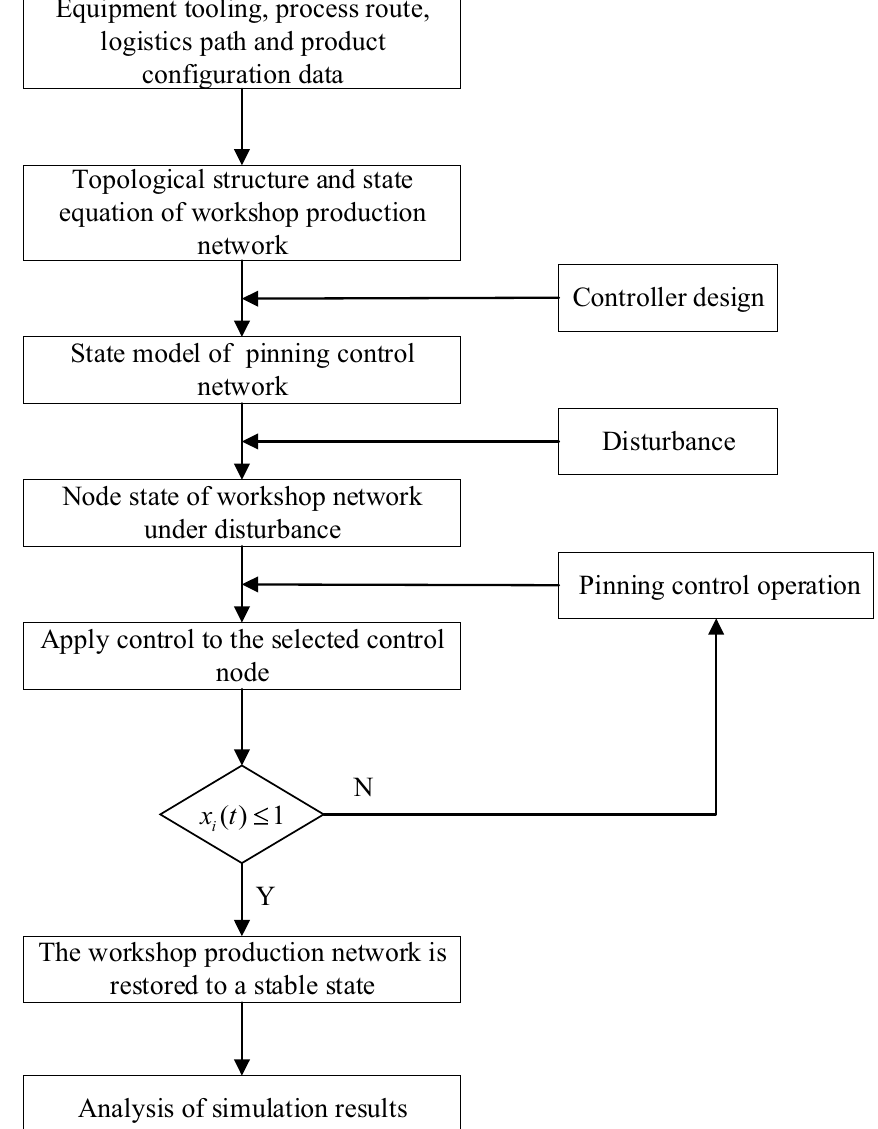
Figure 1. Flowchart of the recovery stability of the pinning control